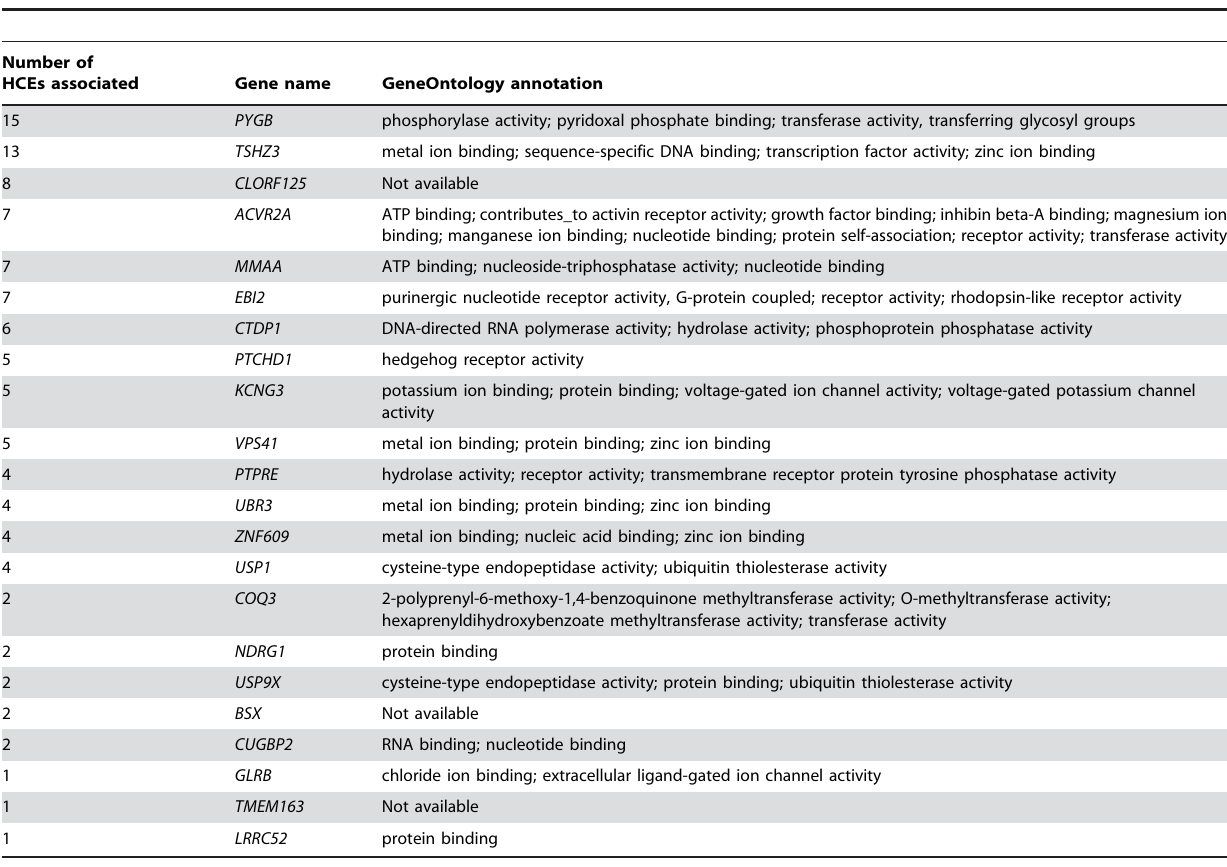
Table 1. Twenty-two single-gene HGLBs.